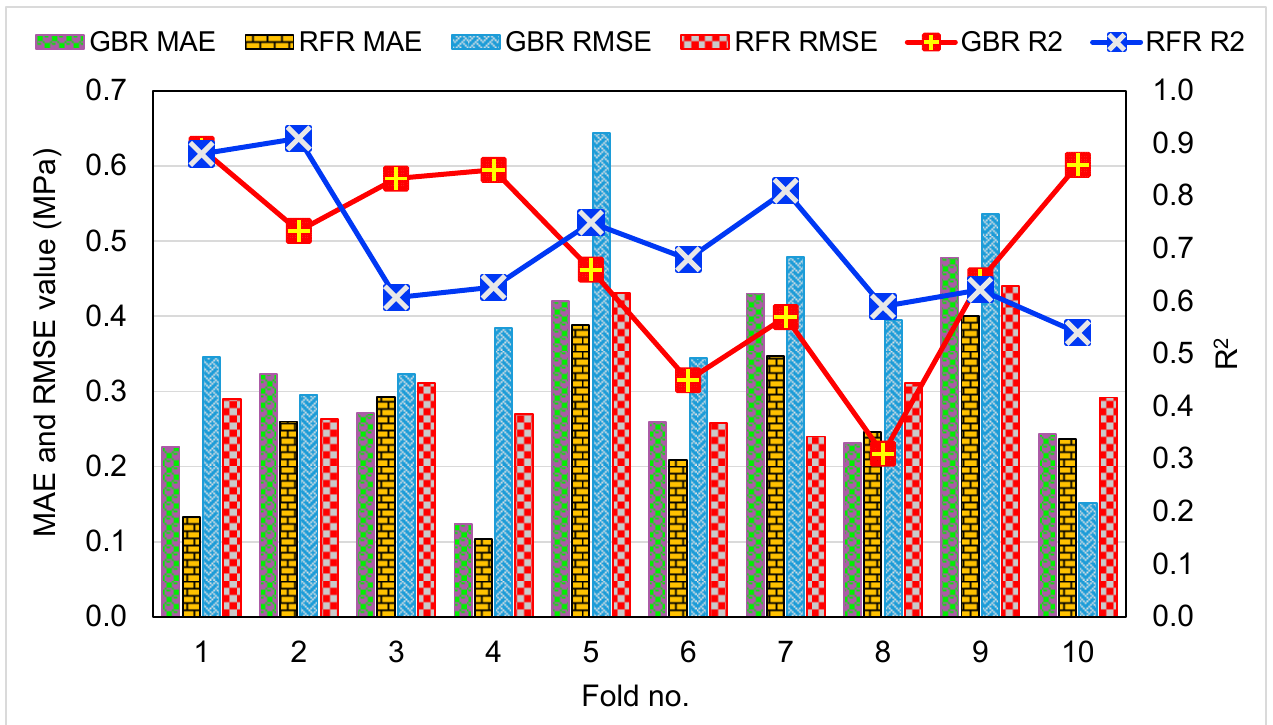
Figure 12. Results of k-fold assessment, indicating MAE, RMSE, and R 2 for GBR and RFR models for the FS estimation.